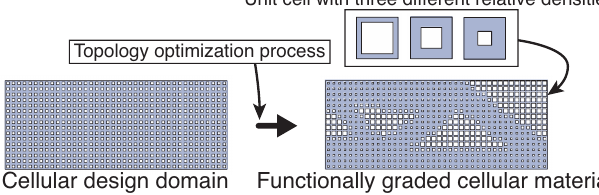
Figure 11. Process to tailor stiffness using Topology Optimization applied to cellular design domains that leads to functionally graded Cellular